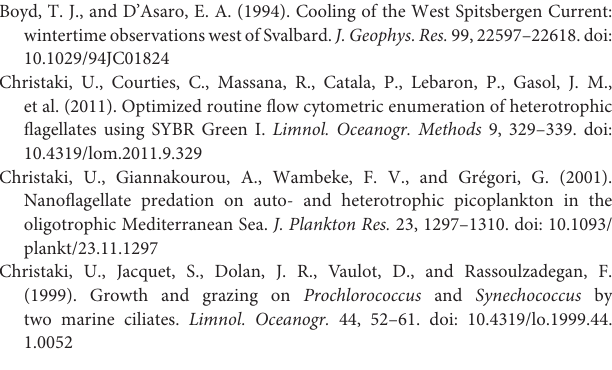
Figure S1 | The abundance (cells mL − 1 ) of Synechococcus (red) and HNF (blue) plotted on the left y-axis during the first 5 days of fractionation experiments performed during the 5 cruises. The fractions < 90 µ m (A-E) , < 10 µ m (F-J) , < 5 µ m (K-O) and < 3 µ m (Q-U) are represented on each row. Exponential functions were fitted (lines) to the abundance providing the net growth rates ( µ ) given in the upper left corner for Synechococcus (red) and HNF (blue). The total prey (sum of Synechococcus , picoeukaryotes and heterotrophic bacteria) to HNF ratio is plotted for each triplicate on he right y-axis (open black circles), the black line connects the daily average prey:HNF ratio. Figure S2 | The abundance (cells mL − 1 ) of Synechococcus (red) and picoeukaryotes (green) for all months within the upper 500 m, except for March where profiles are shown down to 1000 and 3000m. Horizontal light blue lines mark the stations that were influenced by sea ice. Note the different x-axis for different months. Coordinates are given for each station above each graph. Table S1 | Environmental from the cruises containing: dates (mm/dd/yy), latitude and longitude of stations (decimal degrees), depth (m), flow cytometer counts of Synechococcus , picoeukaryotes, nanophytoplankton, heterotrophic bacteria, and nanoflagellates (cells mL − 1 ), the growth rates Synechococcus and HNF (d − 1 ) from the < 90 µ m incubation, salinity, temperature and potential temperature ( ◦ C), CTD-fluorescence (RUF), total chl a and the chl a fraction > 10 µ m ( µ g